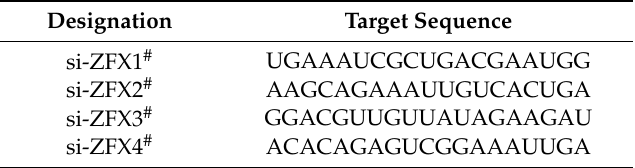
Table 2. Designation and sequences of siRNAs used for ZFX